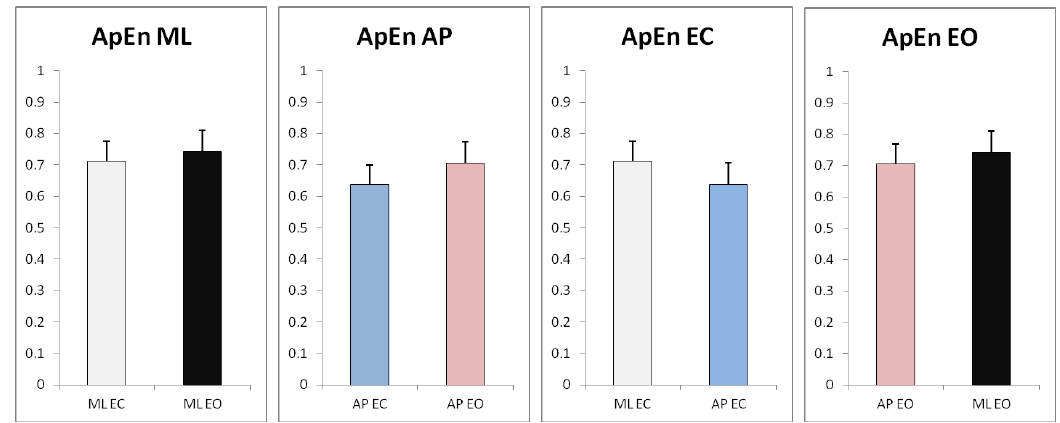
Figure 8. Comparison of ApEn values for quiet standing with and without visual feedback.